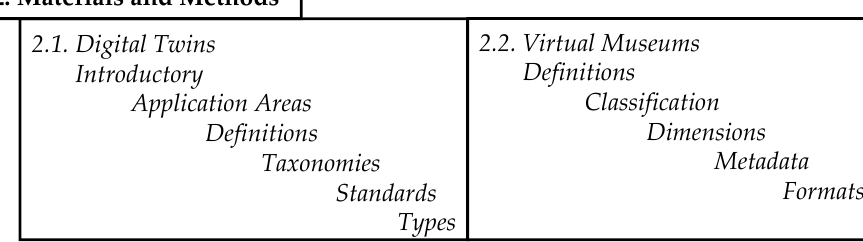
Figure 2. Section 2, subsections and topics.